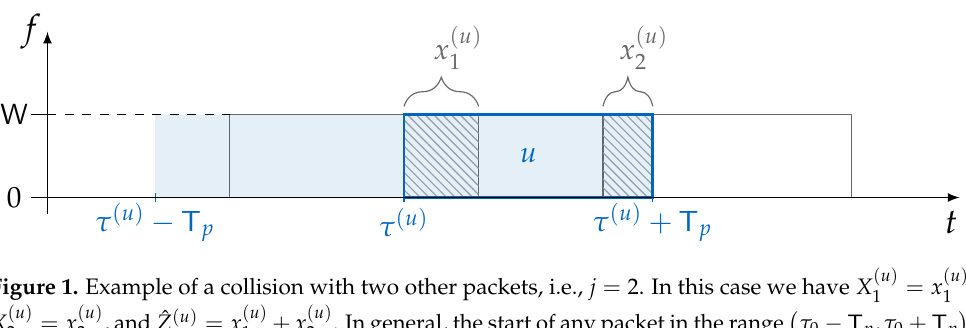
Figure 1. Example of a collision with two other packets, i.e., j = 2. In this case we have X ( u ) ( u ) = x ( u ) + x ( u ) , and ˆ Z ( u ) = x ( u ) . In general, the start of any packet in the range X 2 2 2 1 represented by the shaded blue area, would cause a collision with the data unit of user u